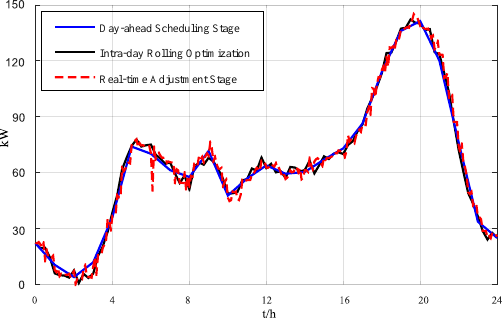
Figure 11. Heat absorption power of heat exchangers at multiple time scales.